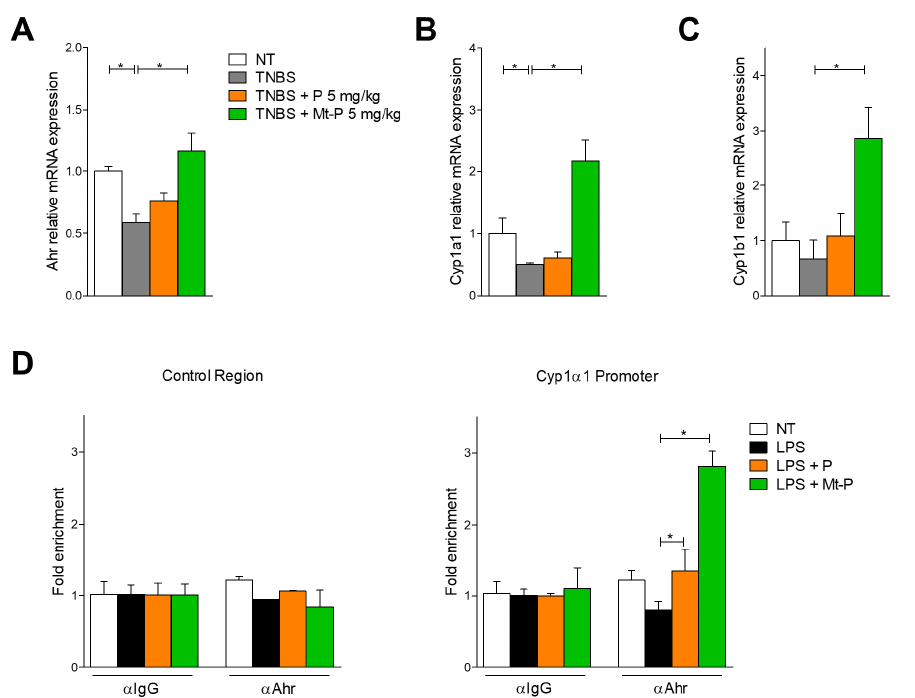
Figure 6. P and Mt-P activate the aryl hydrocarbon receptor (AhR). Relative mRNA expression of ( A ) AhR , ( B ) CYP1a1 , and ( C ) CYP1b1 genes in the colons of mice treated with TNBS alone or in combination with P or Mt-P, assessed by real-time PCR. Data are normalized to Gapdh mRNA. Results are the mean ± SEM of five / eight mice per group (NT = 5; TNBS = 8; TNBS + P 5 mg / kg = 6; TNBS + Mt-P 5 mg / kg = 8) (* p < 0.05). ( D ) ChIP assay of the AhR binding Cyp1a1 promoter in Raw264.7 cells. Cell lysates were immunoprecipitated with anti-AhR or control IgG, and the presence of specific regions in the immune-precipitates was determined by RT-PCR. ( n = 3) (* p <